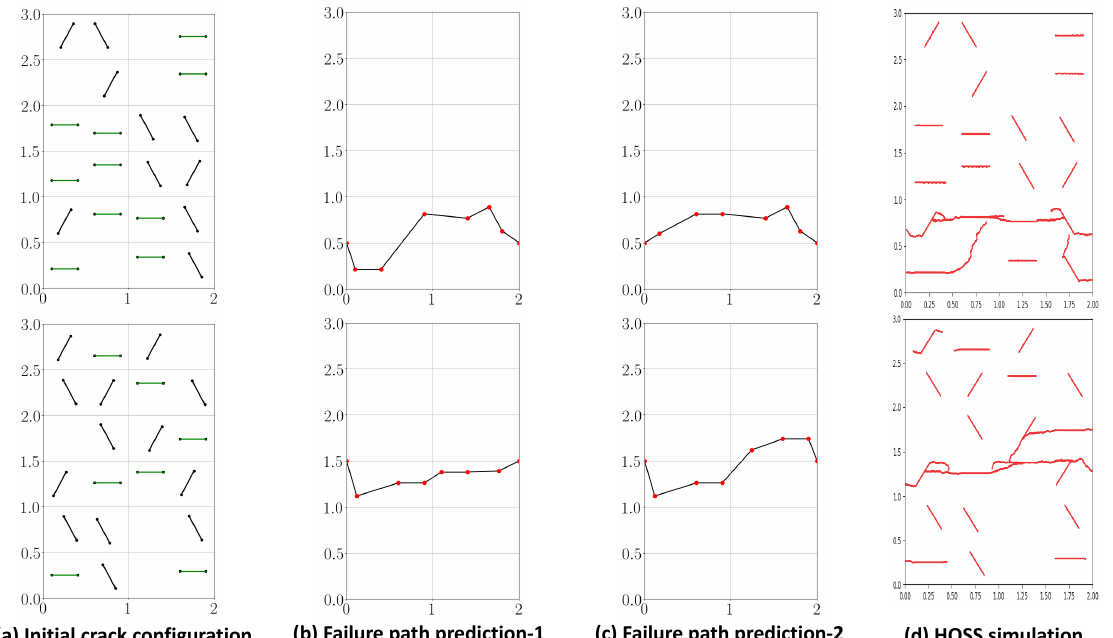
Figure 5. Failure path prediction (best scenarios, multiple predicted failure paths): The above figures show the prediction of multiple failure paths using the proposed method.